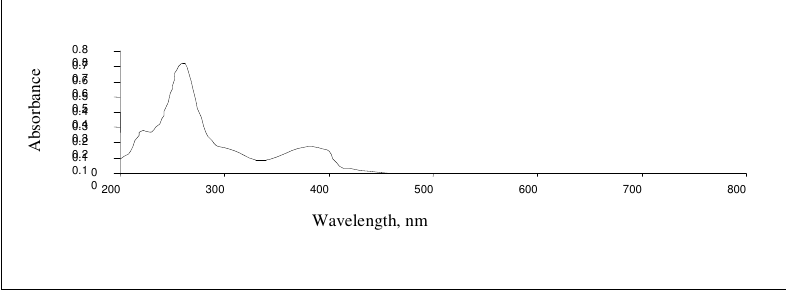
Figure 2. UV spectrum of cinitapride in